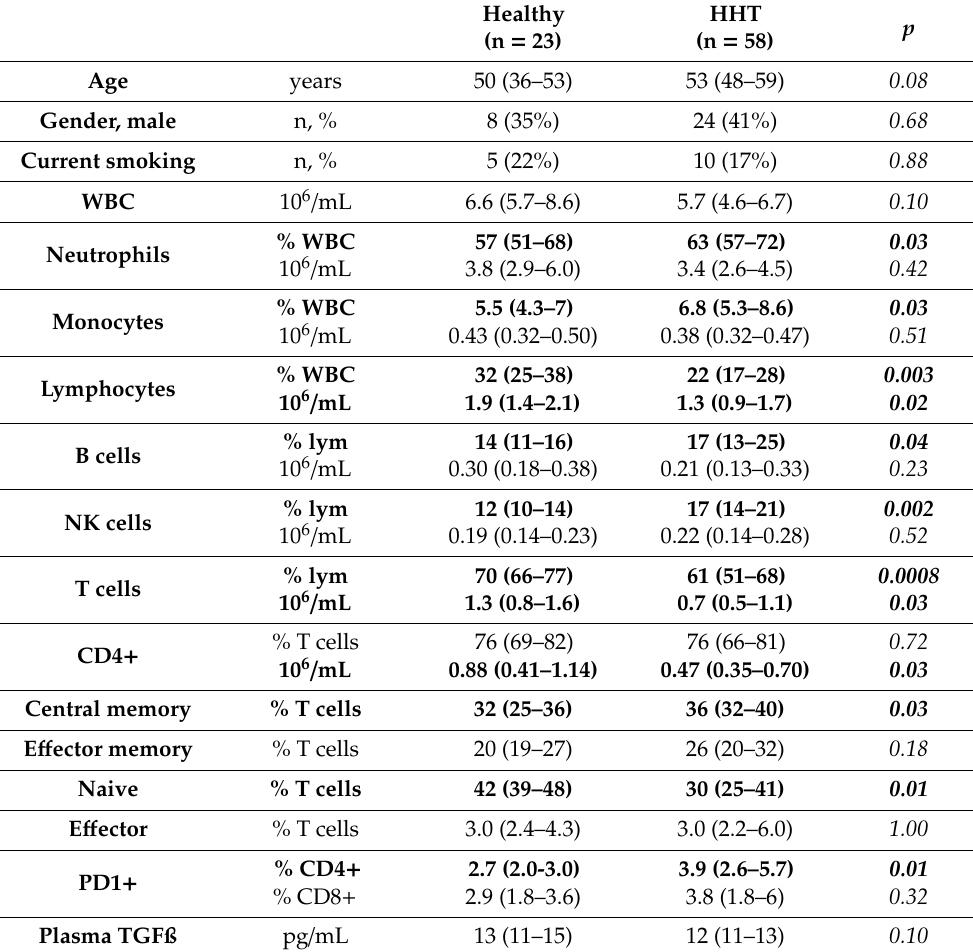
Table 2. Immune status of healthy and HHT patients of comparable